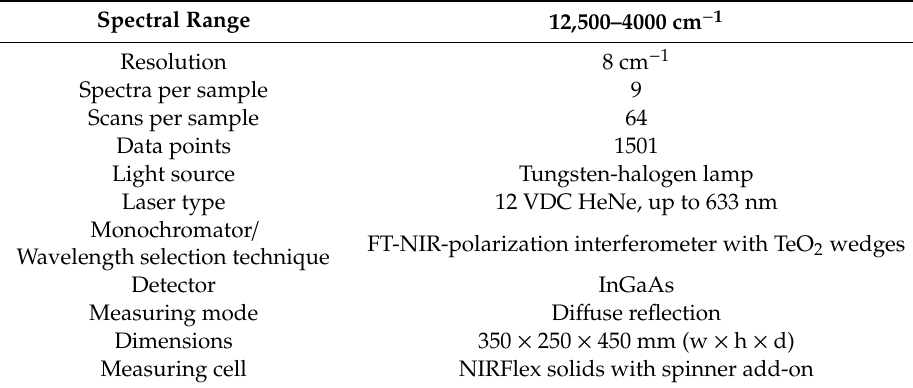
Table 1. Technical characteristics of Büchi NIRFlex N-500